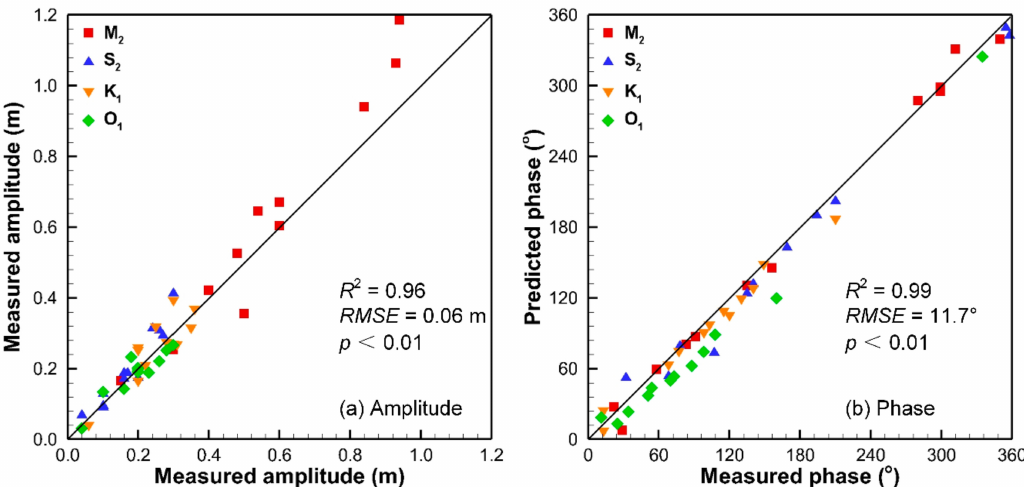
Figure 3. Comparisons between the model-predicted and observed tide amplitudes and phases. The field data are from Admiralty [44].